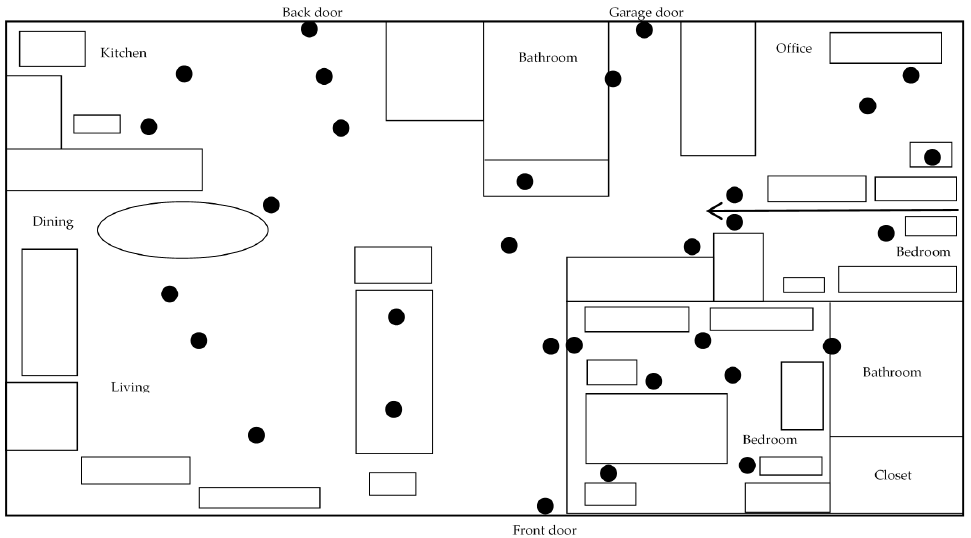
Figure 7. The Aruba home layout; adapted from [59].